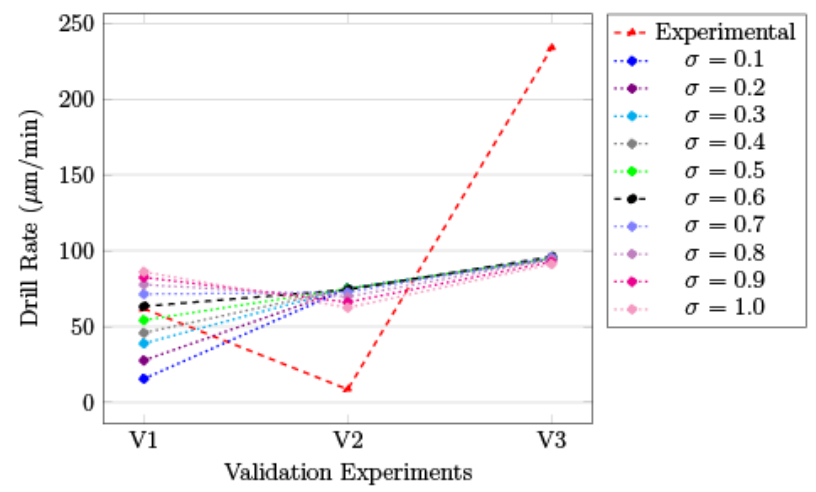
Figure 5. GRNN model testing for DR with different smoothing factors.